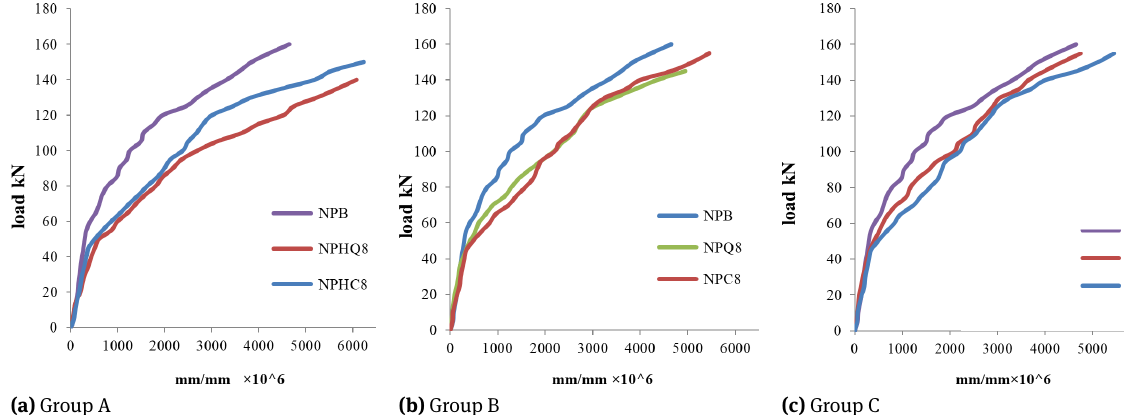
Figure 5: Load versus strain in lower steel reinforcement